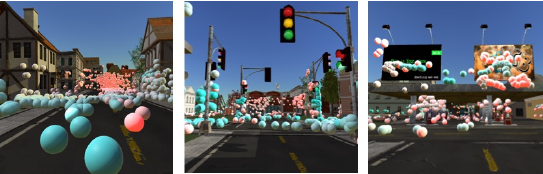
Figure 10: Visualization of gaze points from one subject. Spheres represent hit points of the gaze vector. Color-coded by distance from which it was looked at during the session (far->close = red-